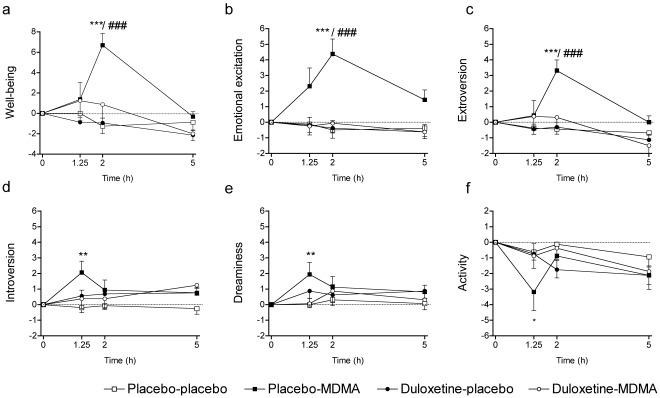
Duloxetine prevented the acute emotional effects of MDMA in the Adjective Mood Rating Scale.MDMA produced a state of well-being (a), emotional excitation (b), increased introversion at drug onset at 1.25 h (d), increased extroversion at 2 h (c), increased dreaminess (e), and decreased performance-oriented activity (f) (*p<0.05, **p<0.01, ***p<0.001, vs. placebo-placebo). Duloxetine prevented MDMA-induced elevations in well-being, emotional excitation, and extroversion (a-c) (###
p<0.001, placebo-MDMA vs. duloxetine-MDMA). Values are expressed as mean+SEM (n  = 16).